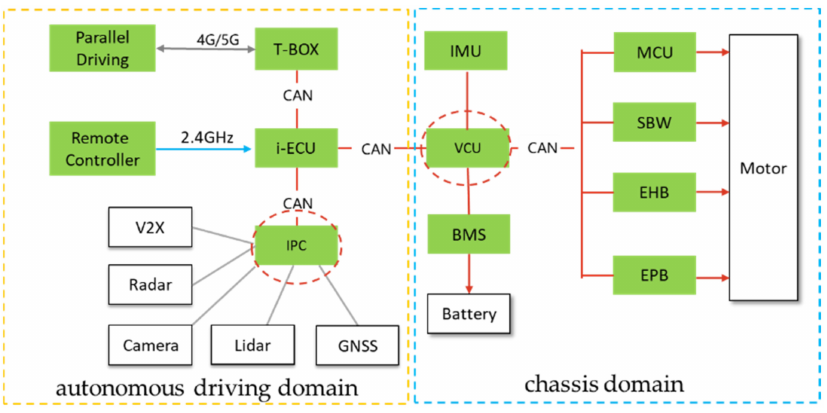
Figure 5. The software architecture of the chassis